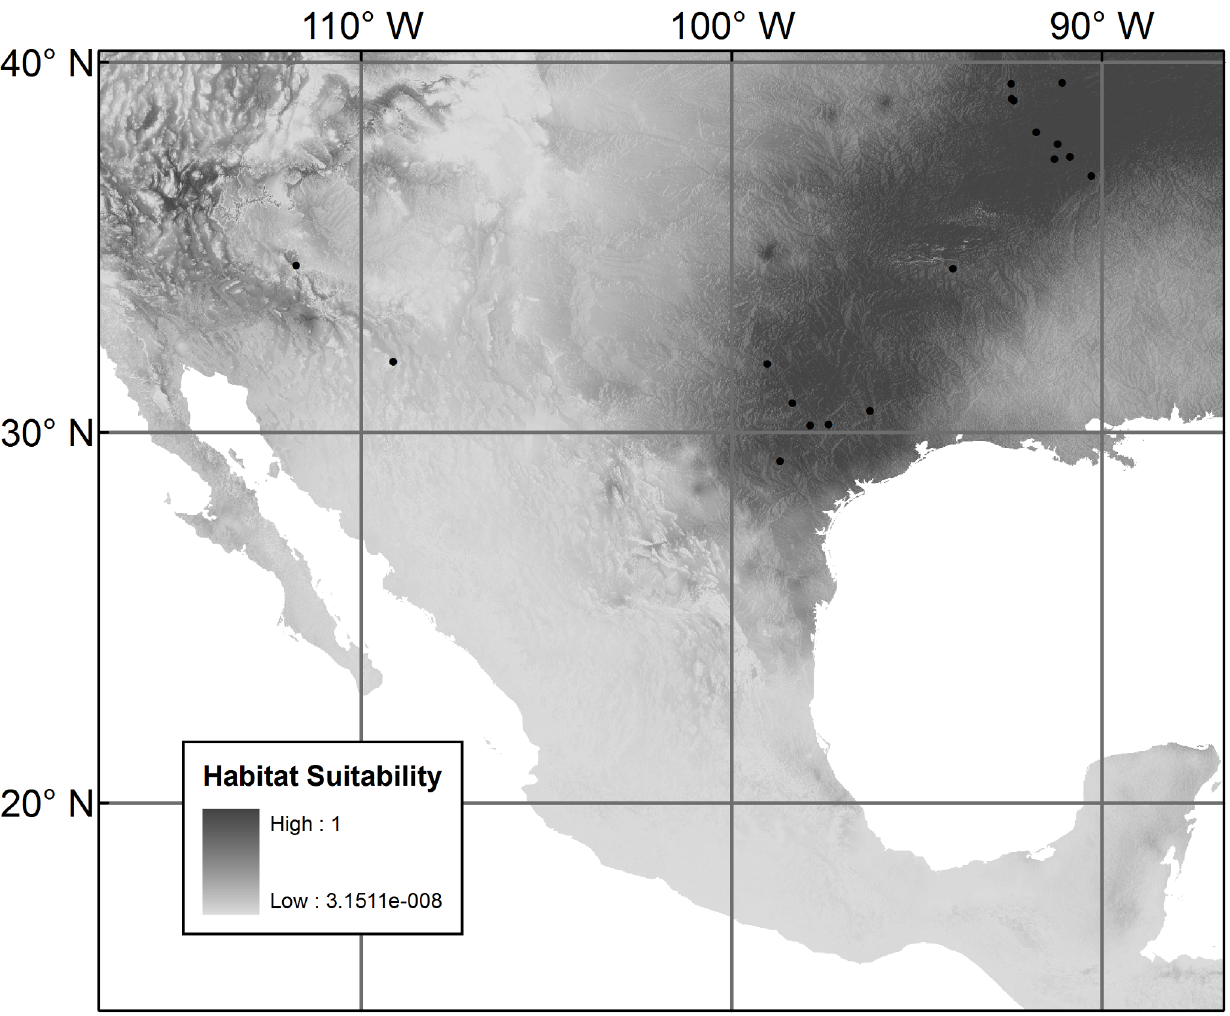
Figure 2. Species distribution model for Triatomasanguisuga . The black dots show the occurrence points used for model construction. Much of the distribution is predicted to be in the eastern United States where the species has been collected from Texas to Florida, However, because of the two occurrence points to the west, a disjoint western distribution is also predicted and merits further investigation, as noted in the text.